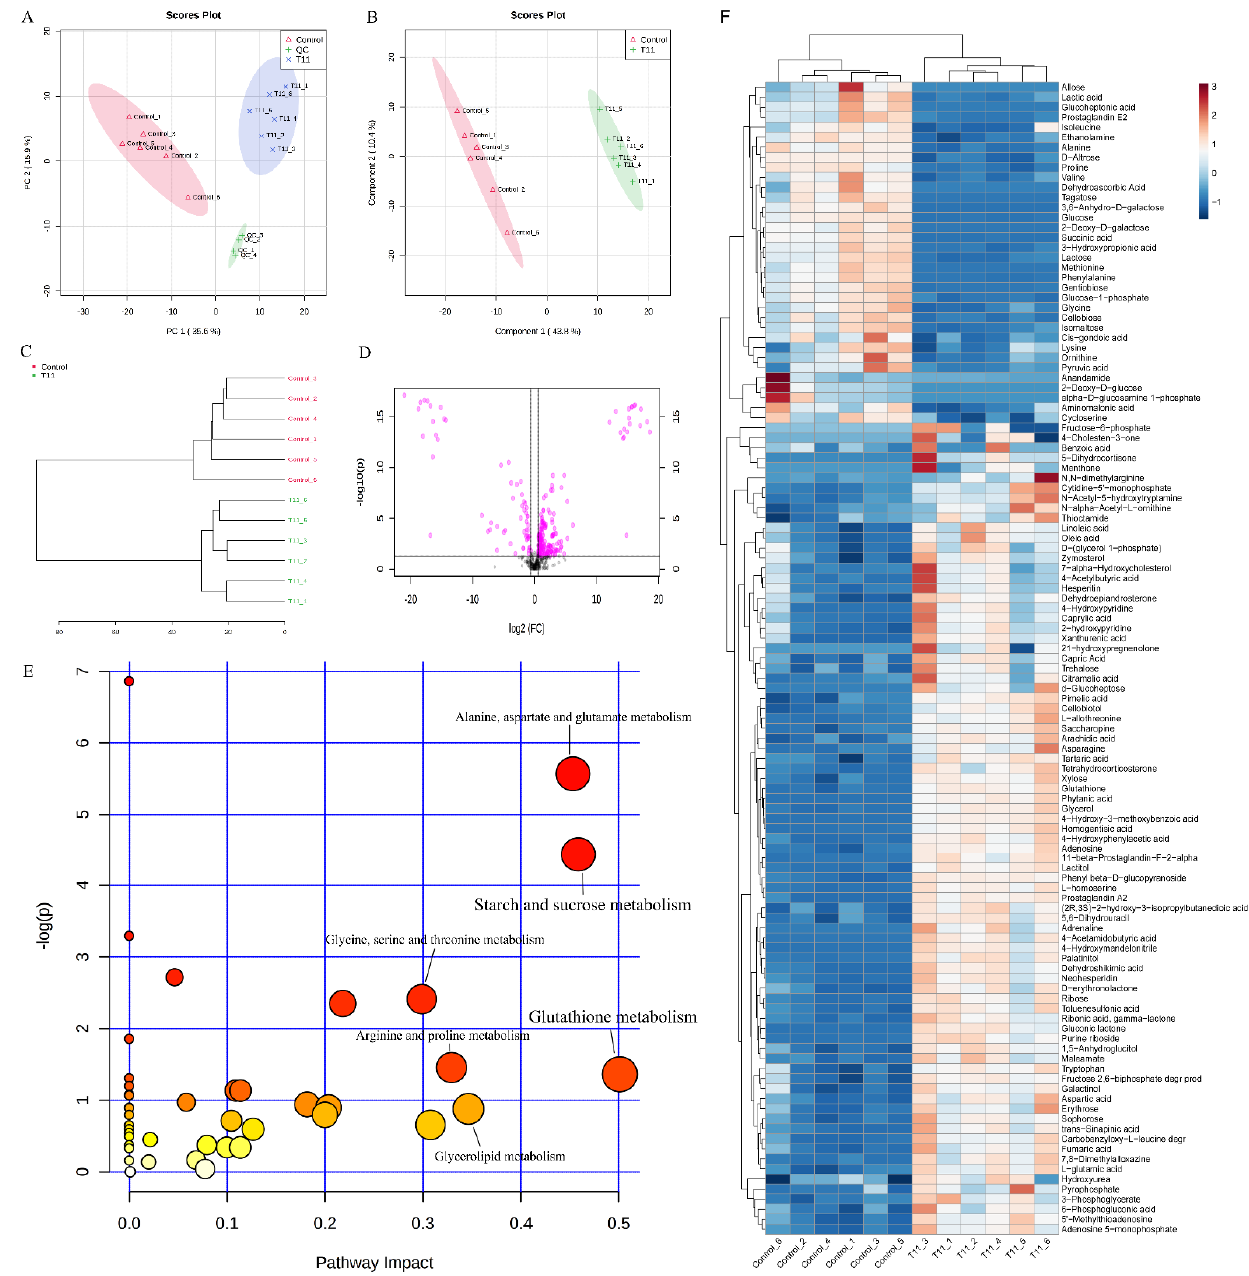
Figure 9. Mycelium metabolomic profiling by GC-TOF-MS. ( A ) PCA score plot of the Con and T11 groups; ( B ) PLS-DA score plot of the Con and T11 groups; ( C ) hierarchical cluster map of the Con and T11 groups; ( D ) the volcano plots of the Con and T11 groups; ( E ) the metabolic pathway impact prediction between the Con and T11 groups in mycelium based on the KEGG online database. The -ln(p) values from the pathway enrichment analysis are indicated on the vertical axis, and the impact values are indicated on the horizontal axis; the smaller the p-value, the redder the circle color, and the larger the influence value, the larger the circle; ( F ) heatmap of relative abundance of significant different metabolites (log 2 (FC) > 1.0, and p < 0.05) in mycelium on the 14th day of fermentation in the Con and T11 groups.